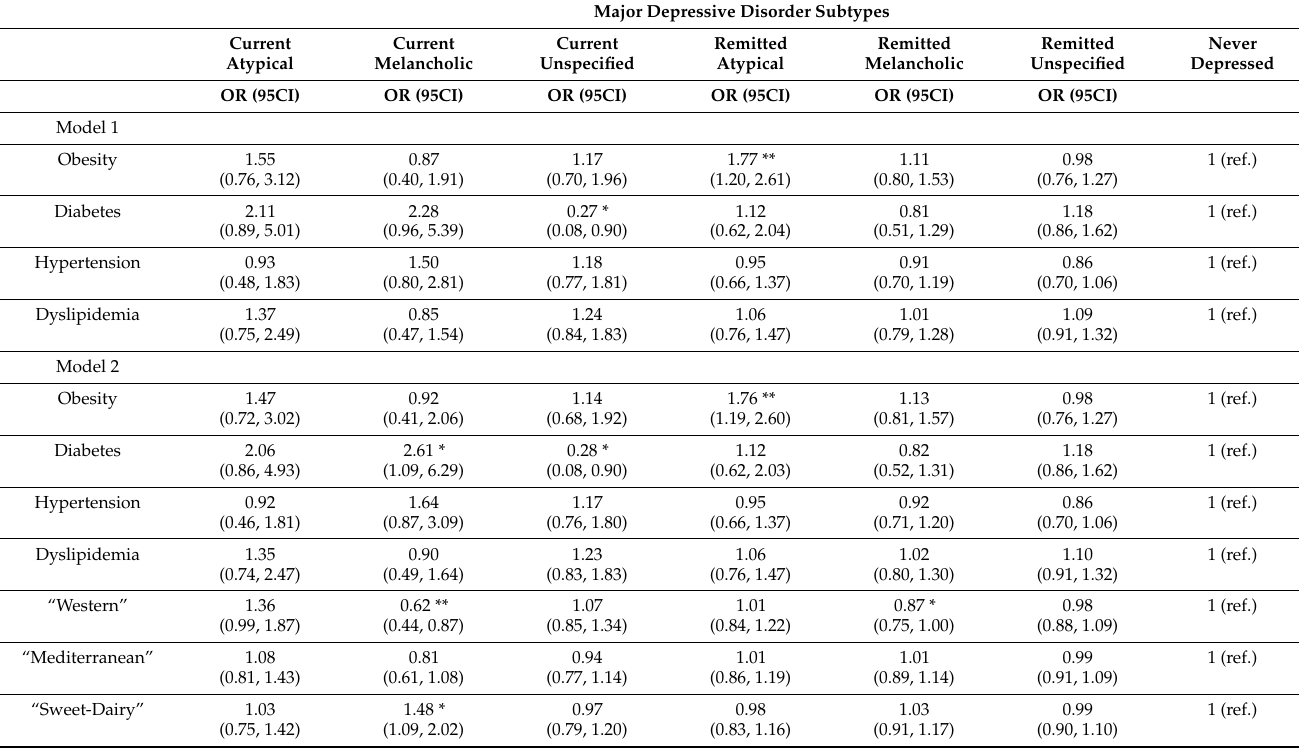
Table 4. Association between cardiovascular risk factors and subtypes of major depressive disorder ( n =